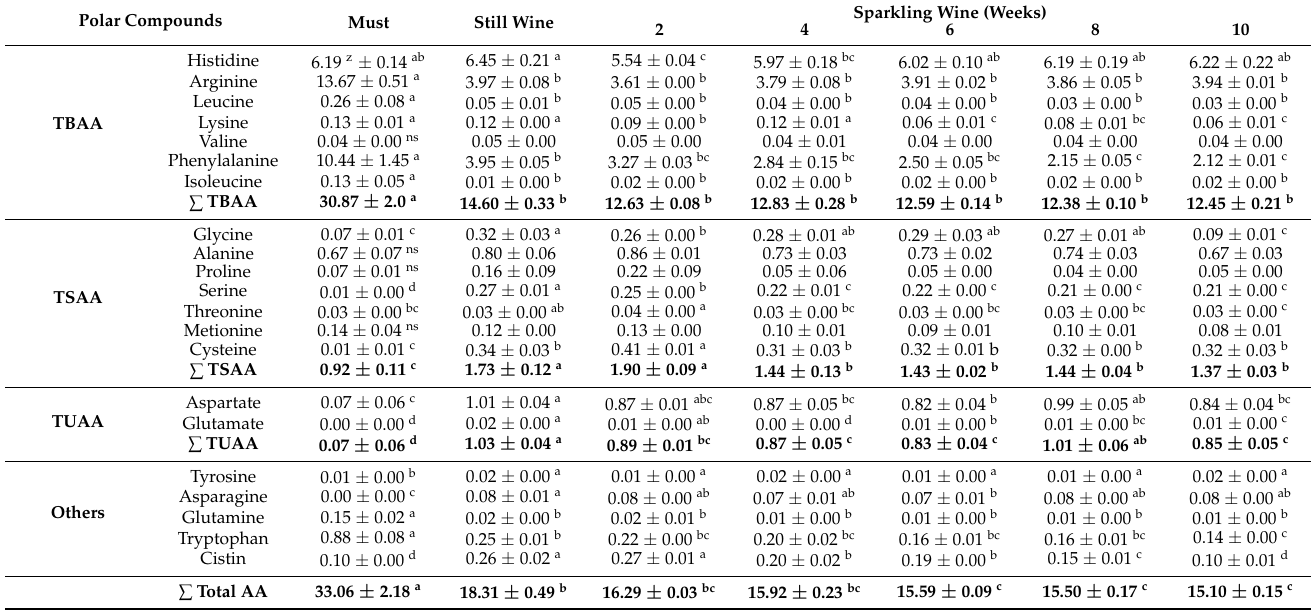
Table 5. Evolution of amino acids ( µ M) of enriched must, still wine, and during the sparkling process of melon-based wine (10